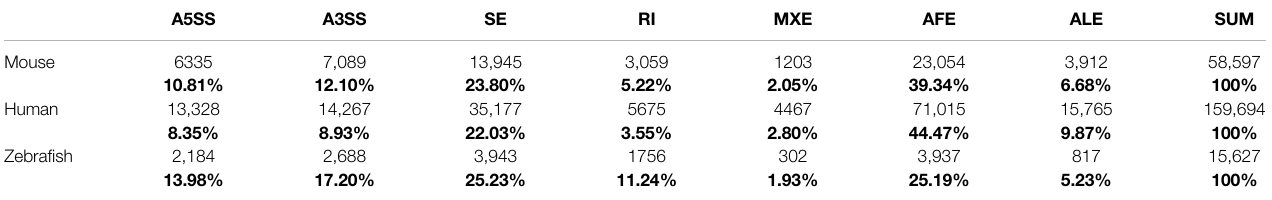
The bold number denotes the percentage of different alternative splicing patterns against the sum of alternative splicing events.